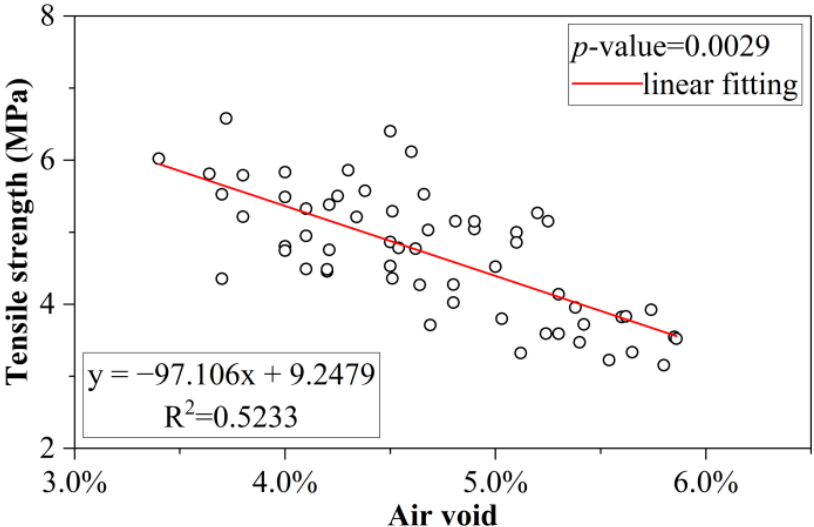
Figure 12. Relationship between tensile strength and air void for the middle layer.